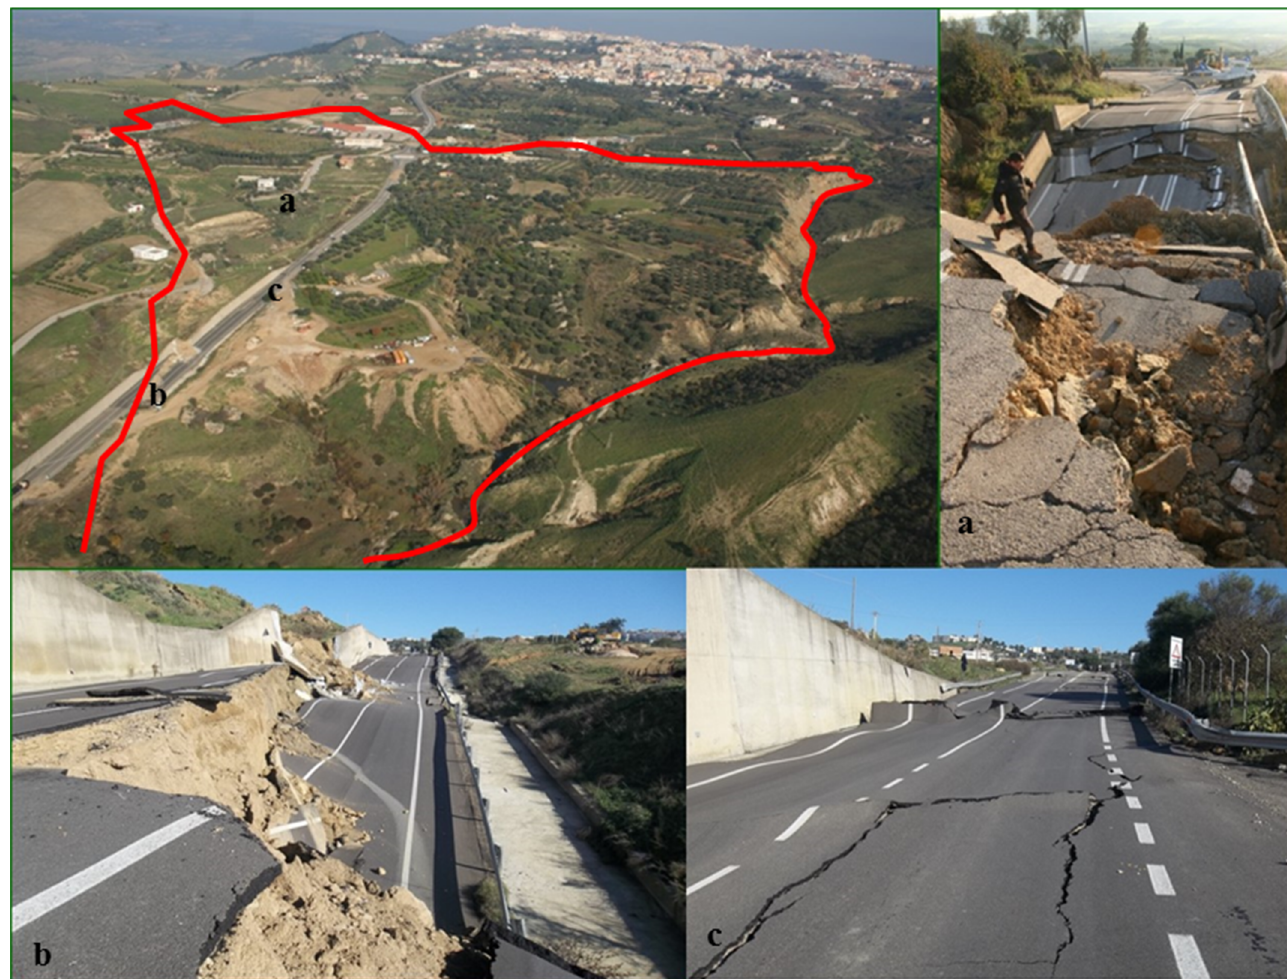
Figure 2. Aerial view of the landslide area and some of the most relevant damage to the infrastructures in the affected area. Labels (a, b, c) indicate the location of the pictures in the aerial view. Later on, the movement involved the lower-left flank of the landslide, resulting in the formation of a swarm of scarps and counterscarps (Figure 2), several tens of meters in length, and creating a series of trenches with a maximum depth of seven to eight meters [11,23]. The whole surface of the landslide area (about 5 × 10 5 m 2 ) directly affected some private houses and warehouses, which were subjected to rigid body translation for few meters downslope and tilting, while a grocery store located in the crown area collapsed (Figure 3). Luckily, no direct damage to people was recorded, despite the rapid activation of the landslide, since the evolution and the consequent deformation of the buildings were relatively slow, allowing the inhabitants to avoid fatal consequences.